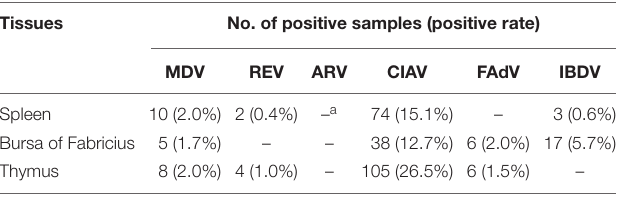
TABLE 5 | No. of positive samples and positive rate for six viruses in the spleen, bursa of Fabricius, and thymus.